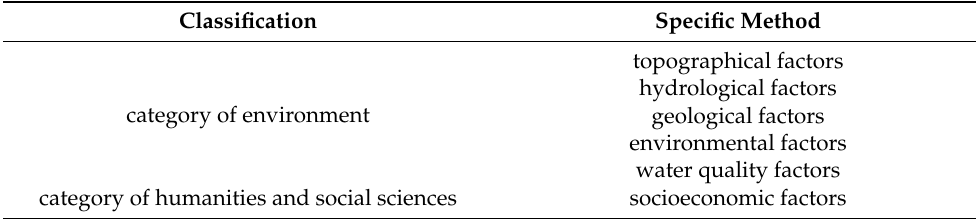
Table 3. Types of factors for dam Table 2. Categorization of dam siting methods.